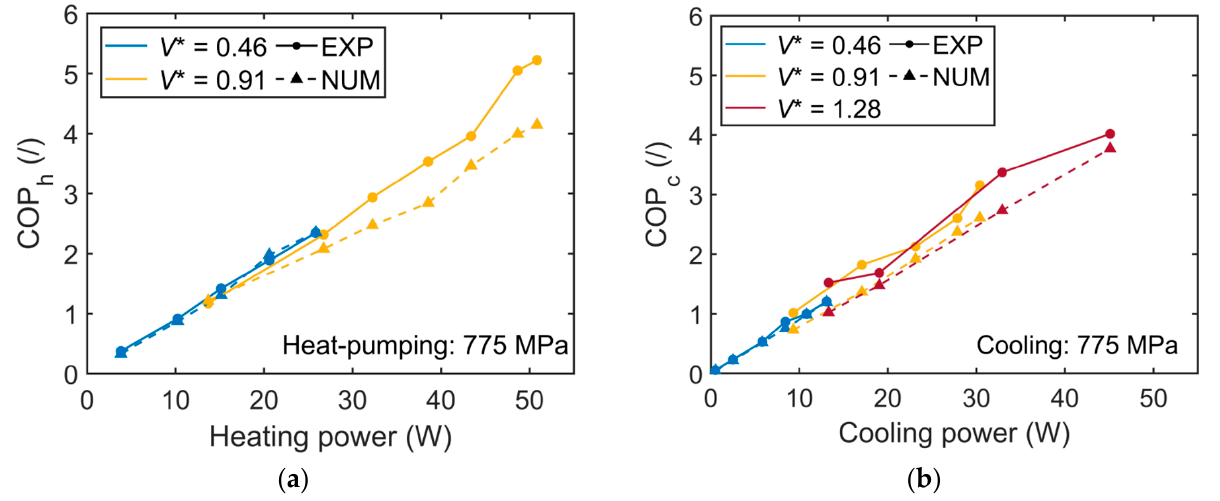
Figure 9. Comparison between experimentally determined and numerically calculated COP—cooling/heating power characteristics for heat-pumping ( a ) and cooling ( b ) at the stress level of 775 MPa. Nevertheless, as shown both experimentally [35] and numerically, the cooling perfor- mance of the AeCR was less efficient than that of the heat-pumping, for which there may